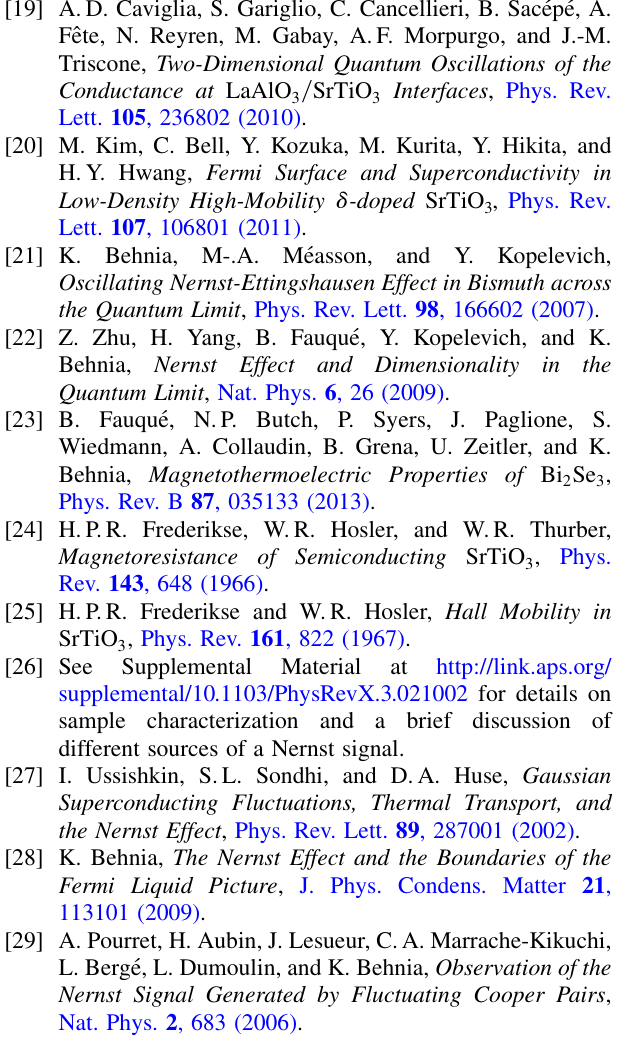
sample characterization and a brief discussion